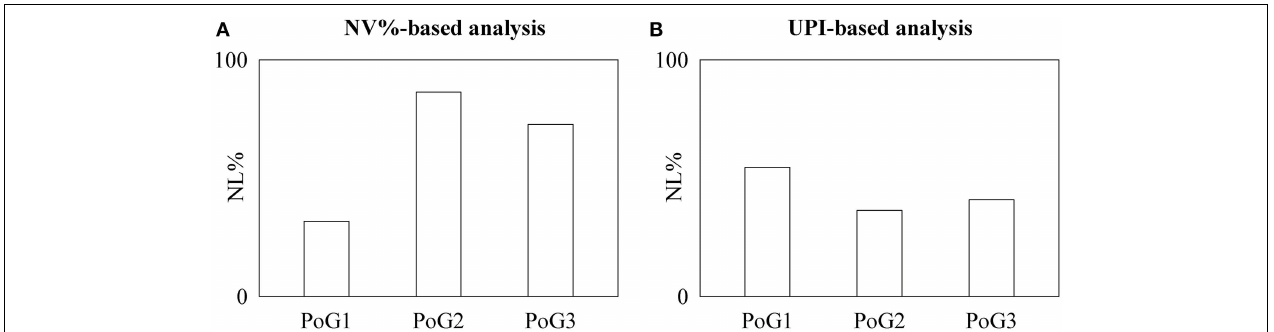
FIGURE 1 | The bargraphs show the percentage of fetuses exhibiting nonlinear dynamics, NL%, as detected by the NV%-based time irreversibility (A) and UPI-based local prediction (B) analyses as a function of the period of gestation (i.e., PoG1, PoG2, and PoG3).